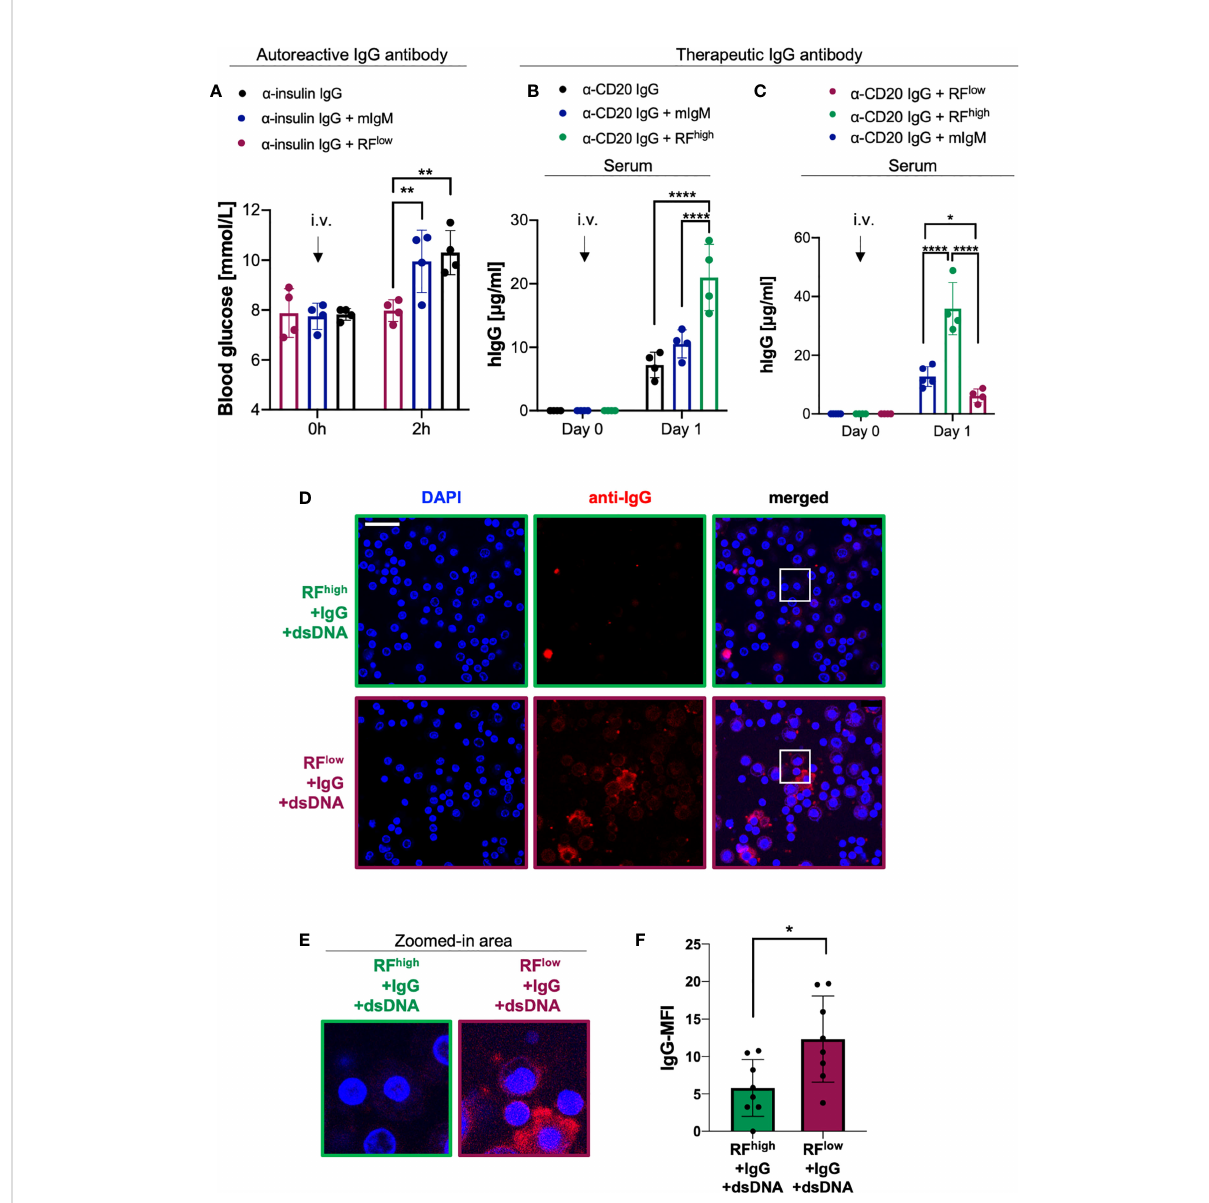
FIGURE 4 RF low controls IgG in vivo function by enhancing its degradation. (A) Blood glucose concentrations of WT mice intravenously (i.v.) injected with 100 µg a -insulin IgG alone (black bar, n = 4) or in combination with 20 µg RF low (purple bar, n = 4) or mIgM control (blue bar, n = 4) measured at indicated time points. Mean ± SD, statistical signi fi cance was calculated using two-way ANOVA with Tukey ’ s multiple comparisons test. **p < 0,01. (B) Serum human IgG concentrations of WT mice at day 0 and day 1 after a single i.v. injection of 20 µg of a -CD20 human IgG (rituximab) alone (black lined bar, n = 4) or in combination with RF high (green lined bar, n=4) or mIgM control (blue lined bar, n = 4) as measured by ELISA. Mean ± SD, statistical signi fi cance was calculated using two-way ANOVA with Tukey ’ s multiple comparisons test. ****p<0,0001. (C) Serum human IgG concentrations of WT mice at day 0 and day 1 after a single i.v. injection of 20 µg a -CD20 human IgG (rituximab) in combination with RF high (green line, n = 4), with RF low (purple line, n = 4) or mIgM control (blue line, n = 5) as measured by ELISA. Mean ± SD, statistical signi fi cance was calculated using two-way ANOVA with Tukey ’ s multiple comparisons test. *p < 0,05; ****p < 0,0001. (D) Macrophage phagocytosis assays depicting the levels of macrophage immune complexes uptake. Macrophages were probed with complexes composed of RF high +IgG+dsDNA (top, green squared) or with complexes consisting of RF low +IgG+dsDNA (bottom, purple squared). Scale bar 29 µm. Images are representative of three independent experiments. (E) 4X Zoom-in of the white-squared areas in Figure 4D as indicated above each image. (F) Quanti fi cation of mean fl uorescent intensity (MFI) of IgG phagocytosed by macrophages detected using anti-IgG antibody: RF high +IgG+dsDNA (green bar), RF low +IgG+dsDNA (purple bar). Data were normalized to IgG-MFI of macrophages probed with immune complexes composed of IgG and dsDNA (shown in Supplementary Figure 4). Dots represent single cells (n = 8). Mean ± SD, statistical signi fi cance was calculated using unpaired t test with Welch ’ s correction. *p <